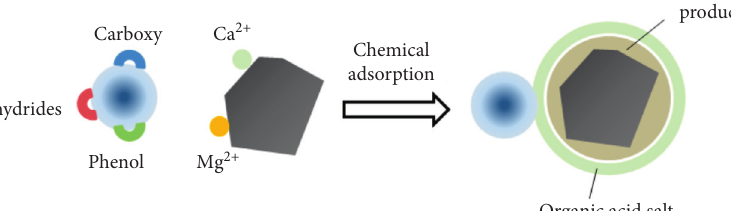
Figure 13: Chemical adsorption of CBEM by